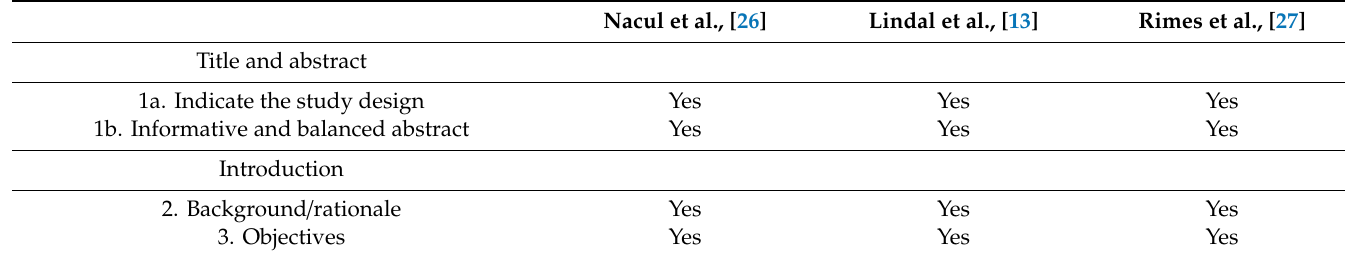
Table A2. The reporting quality of the included studies evaluated by the observational studies in epidemiology (STROBE)